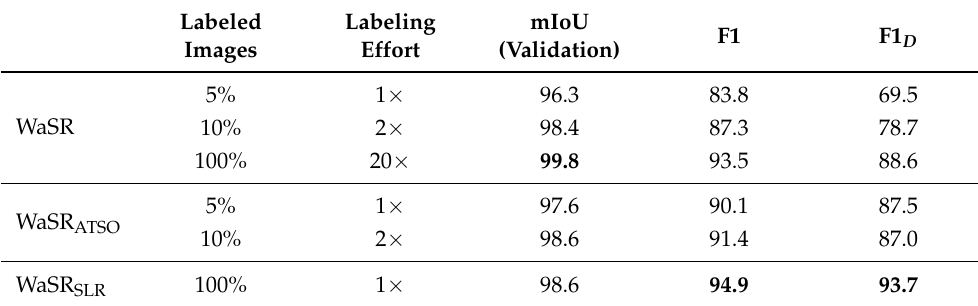
Table 3. Annotation efficiency of methods (percentage of labelled images, and labeling effort relative to SLR) in terms of obstacle detection performance on MODS (F1 and F1 D ) and segmentation on the MaSTr1325 validation set (mIoU). Best results for each metric are denoted in